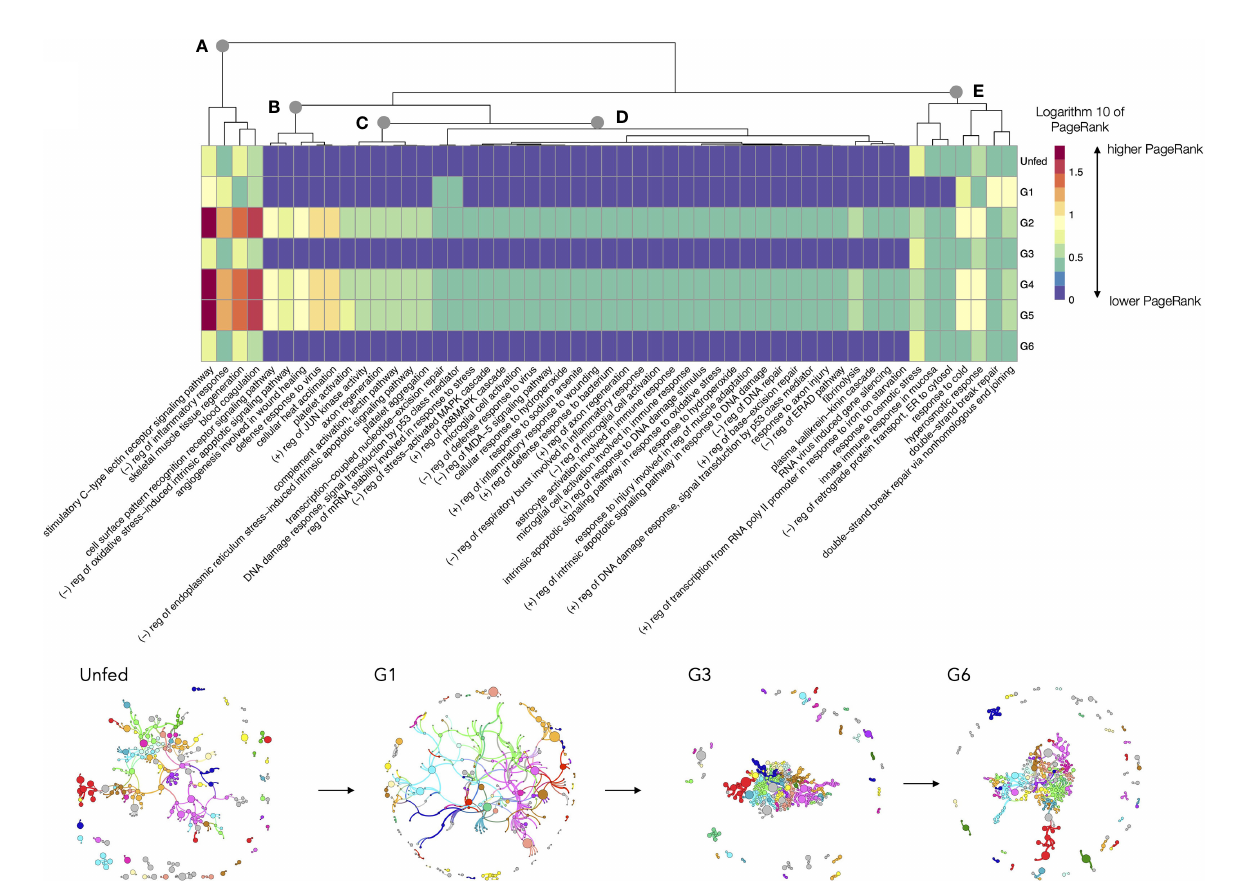
FIGURE 8 | A heatmap displaying the values of the log10 of PageRank of the low-level processes in the subnetwork of processes linked with “ response to stress ” in R. sanguineus . The chart displays only the processes with a rate of change between organs located in the top percentile 70% of variability (i.e., only the 30% of processes, those with highest variability, are shown). The heatmap shows the processes grouped according to a dendrogram (top) grouping those processes with similar patterns of variability. Dots labelled (A – E) show breaking points of the dendrogram, intended only as a help for interpretation. The tick group (unfed, G1 to G6) is included at the bottom of the fi gure, following the terminology of the original data by Tirloni et al. (2020). Subnetworks of proteins and processes for selected groups are included at bottom to show its topology. Colors mean for modularity, or groups of proteins and processes that tend to appear linked signi fi cantly more frequently than with others. The size of each circle is portion to its PageRank and the width of the lines denote the strength of association. To note the cohesively linked dots in ticks belonging to G1. However, G3 and G6 show a large group of dots tightly located in the center of the network, denoting large interactions among them, while some of the proteins and processes that do not belong to the nucleus and are located in the